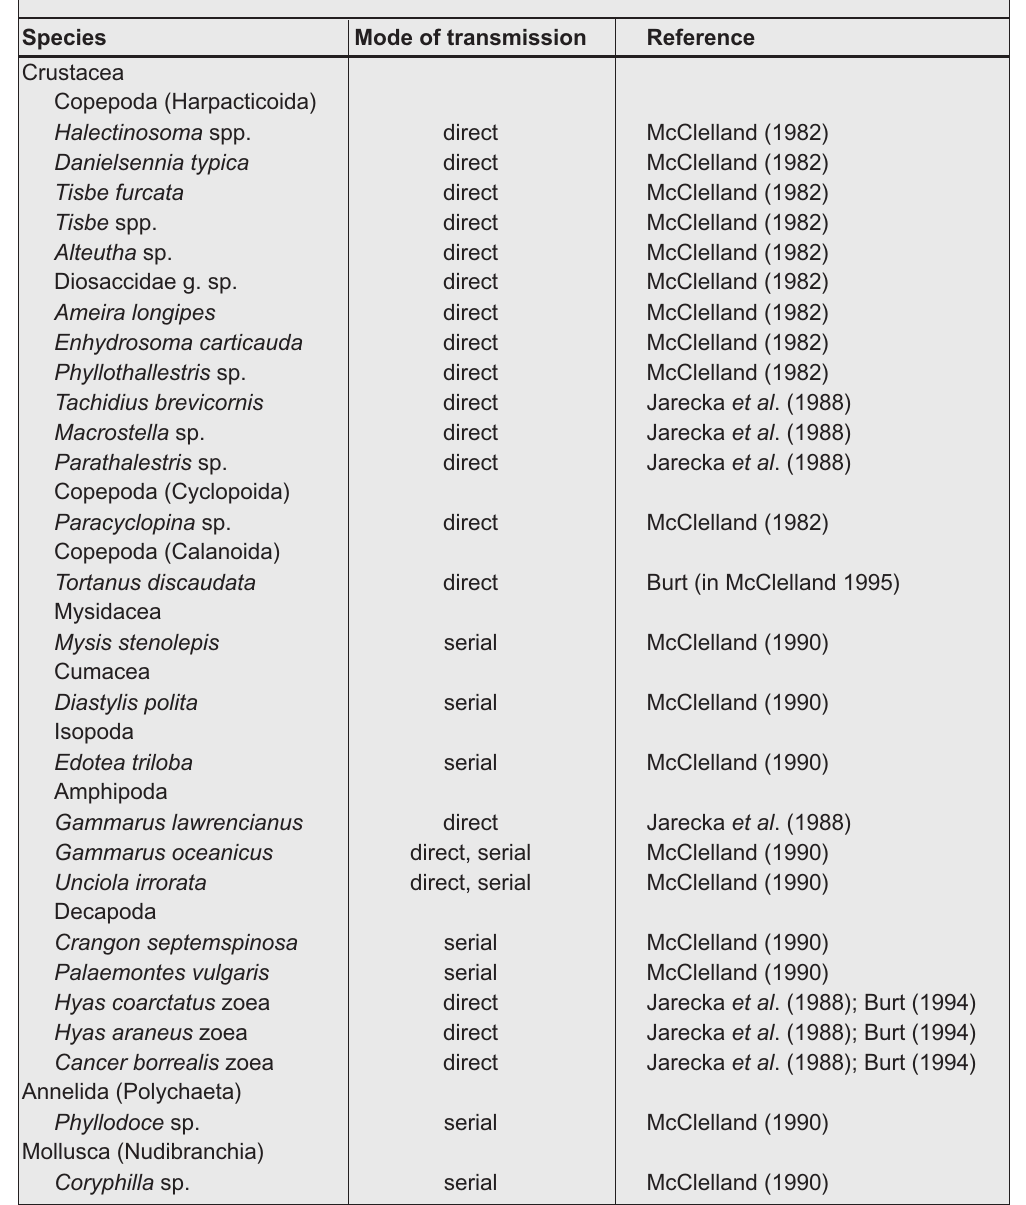
Table 1 . List of invertebrates experimentally infected with the sealworm ( Pseudoterranova deci- piens ). Direct transmission refers to exposing the invertebrate to the free-living infective larvae. Serial transmission refers to exposing the invertebrate to an infected precursor invertebrate host, such as a